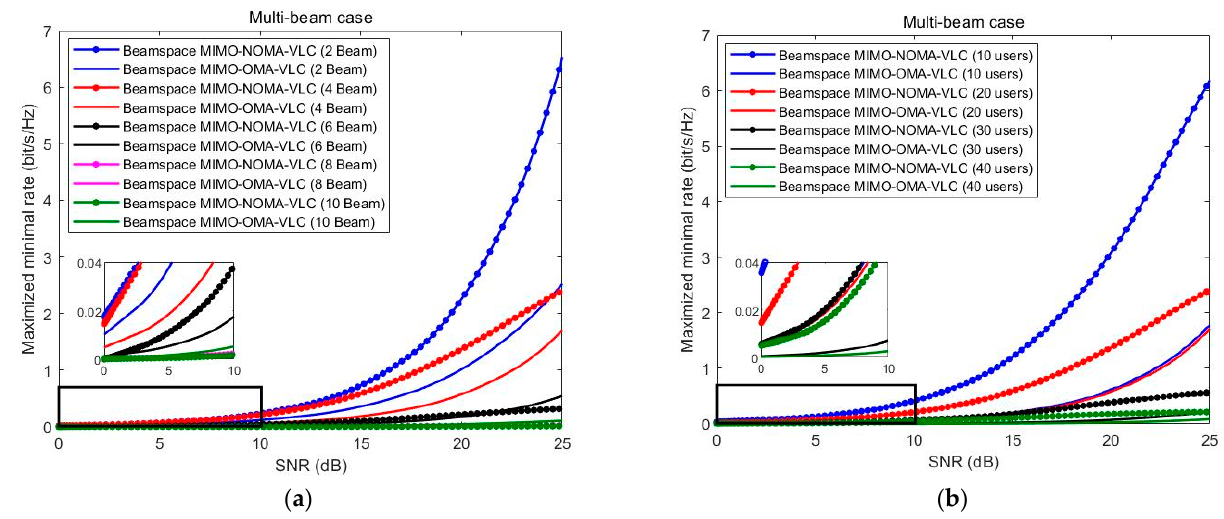
Figure 7. ( a ) The minimum rate varies with SNR in the case of multiple beams. ( b ) The minimum rate varies with SNR in a multi-user case. rate varies with SNR in a multi-user